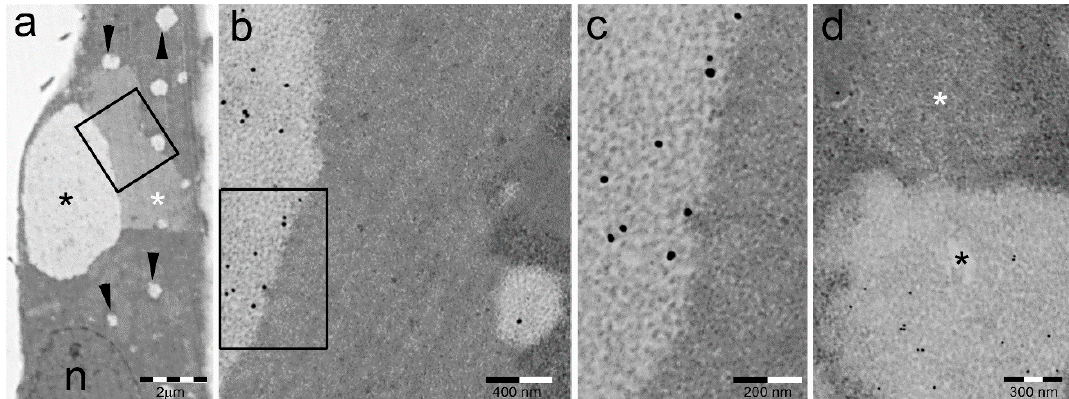
Figure 6. PaCSs and sequestosomes coexist in HeLa cells. ( a ) Ultrastructural identification of a sequestosome (white asterisk) adherent to a large PaCS (black asterisk) in the cytoplasm of a HeLa cell cultured under basal conditions. Note the presence of several small PaCSs (some with arrowheads). N, nucleus. The boxed area in ( a ) is enlarged in ( b ), and further in ( c ), to show PaCS' distinctive barrel-like particles and FK1 antibody reactivity for pUbPs (see the immunogold particles on light gray areas) as opposed to the thin granulofibrillary structure and FK1 unreactivity of the sequestosome (no immunogold particles on dark gray area). ( d ) Another PaCS-adhering sequestosome (white asterisk) that is unreactive to proteasome immunogold, which labels the PaCS (black asterisk). Reproduced and adapted from Reference [81] under a Creative Commons Attribution (CC BY 3.0) License.